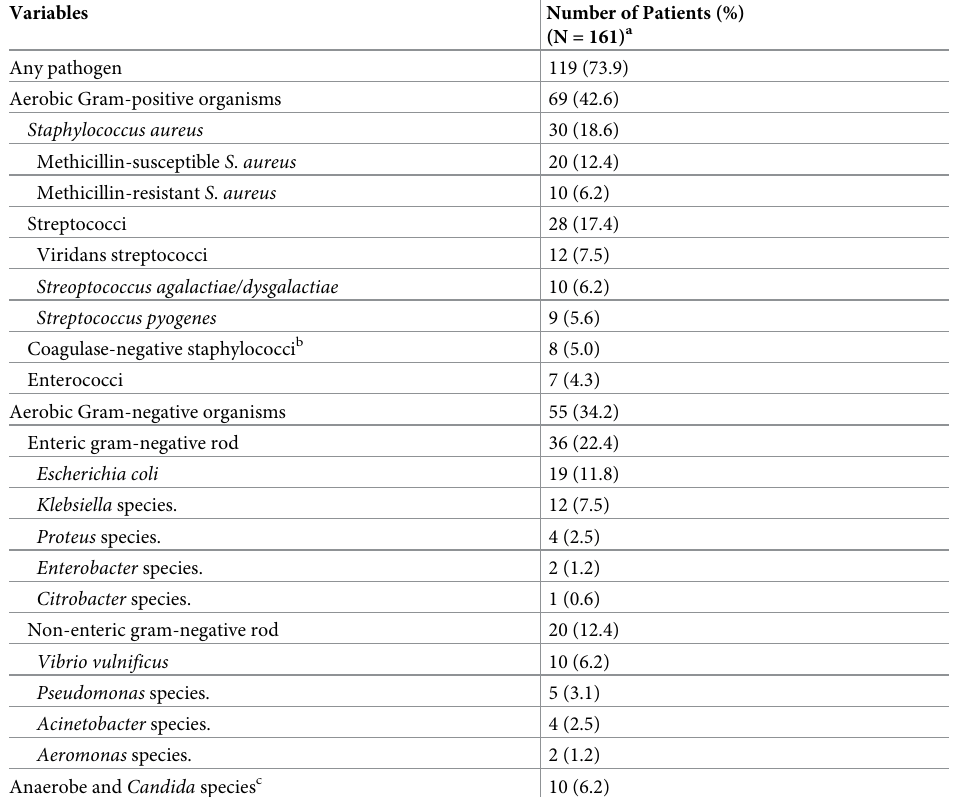
Table 2. Identified microbial etiologies in patients with community-onset necrotizing